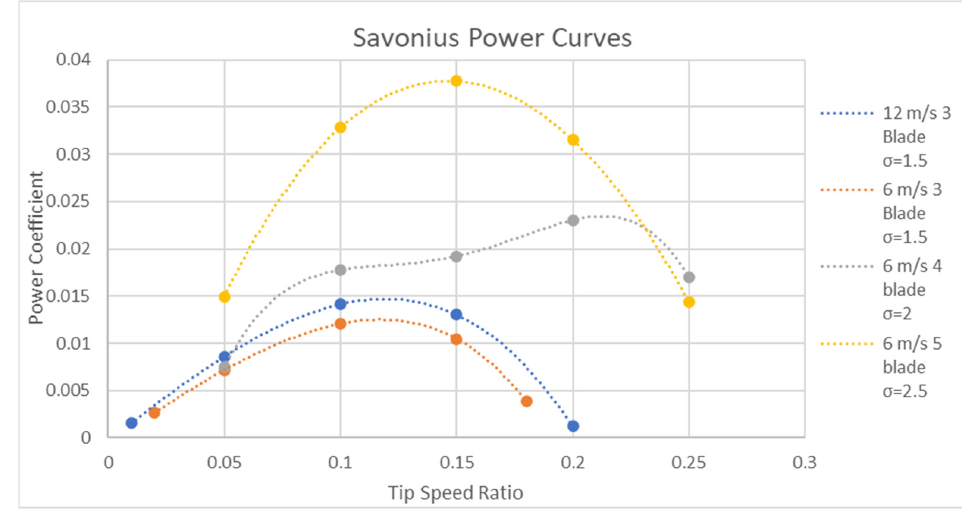
Figure 17. Savonius design comparison.